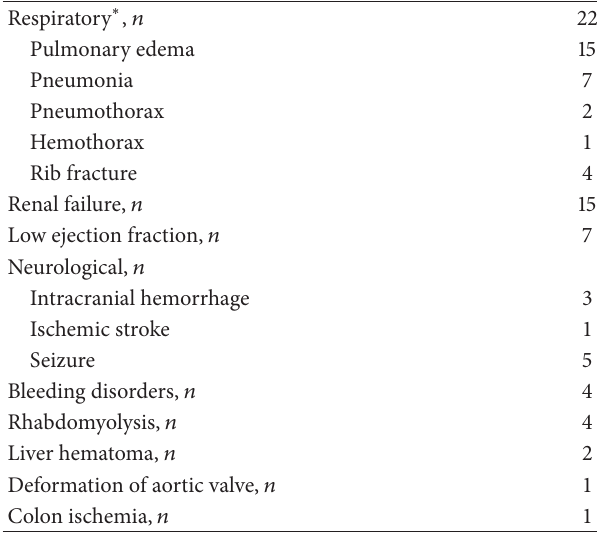
Table 4: Prolonged CPR related complications after prolonged